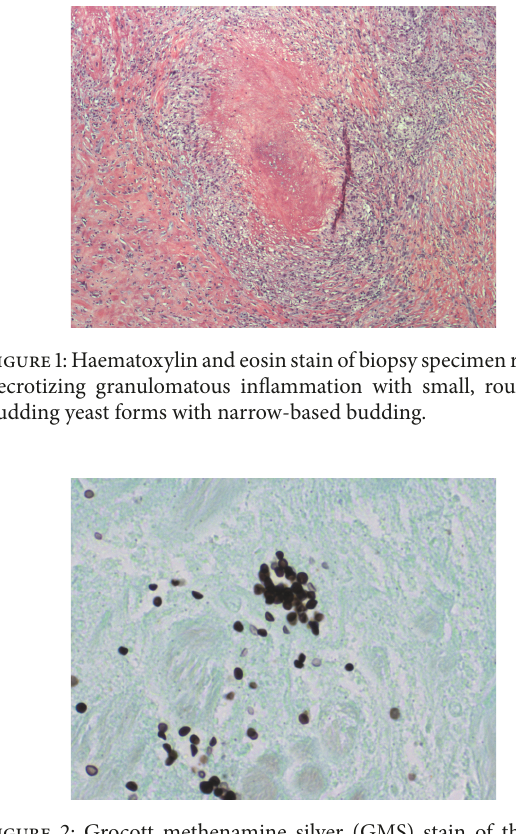
Figure 2: Grocott methenamine silver (GMS) stain of the same biopsy specimen as in Figure